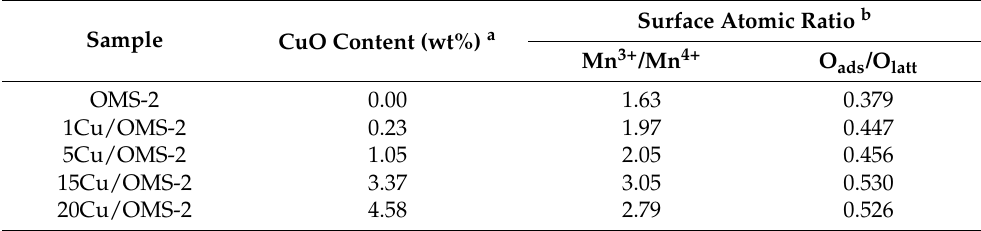
Table 2. CuO contents, surface Mn 3+ /Mn 4+ and O ads /O latt atomic ratios of the OMS-2 and x Cu/OMS- 2